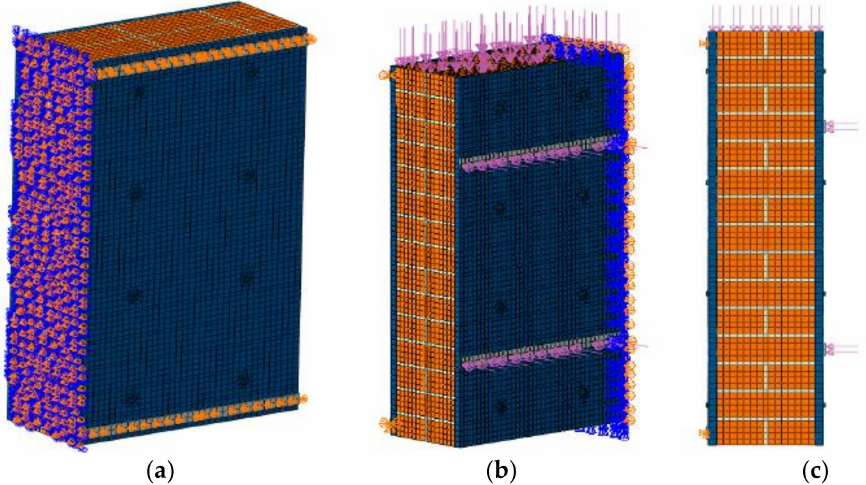
Figure 18. Masonry wall model (2SRW1115-NM as an example): ( a ) boundary conditions, ( b ) loading, ( c ) side view with indication of applied loads and